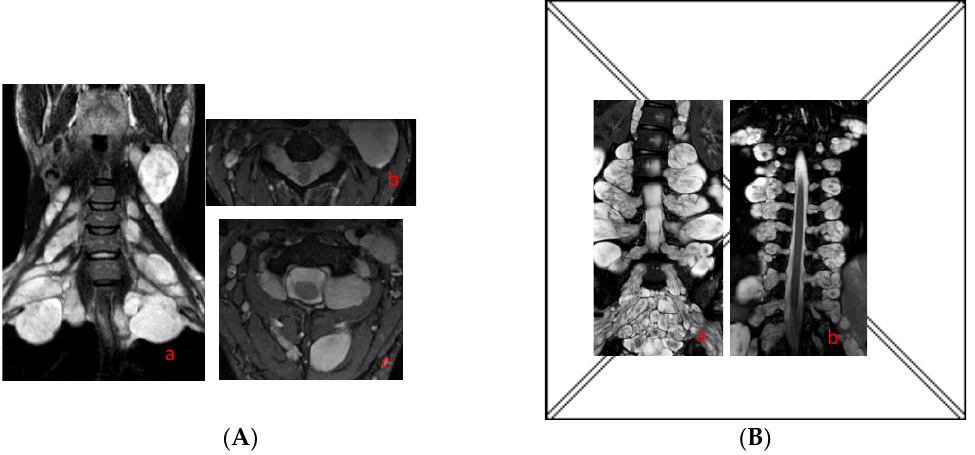
Figure 1. ( A ) Coronal ( a ) and axial ( b,c ) T2-weighted images showing symmetrical neurofibromas in the cervical spinal roots; ( B ) coronal ( a,b ) T2-weighted images showing symmetrical neurofibromas in the dorsal lumbar and sacral spinal roots.